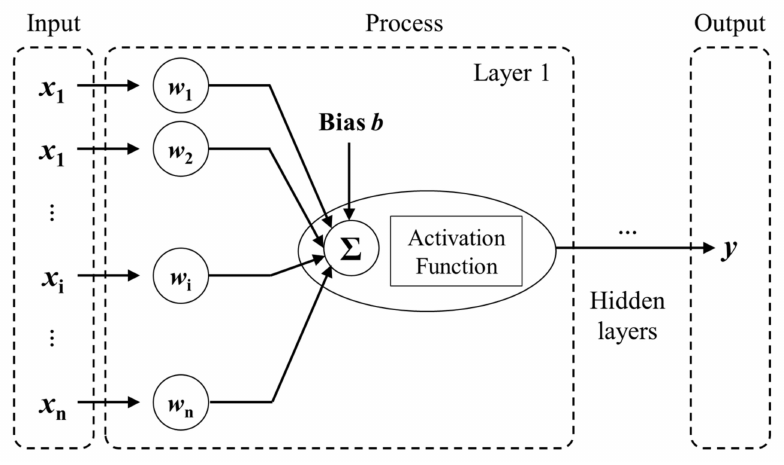
Figure 5. A sketch of the ANN